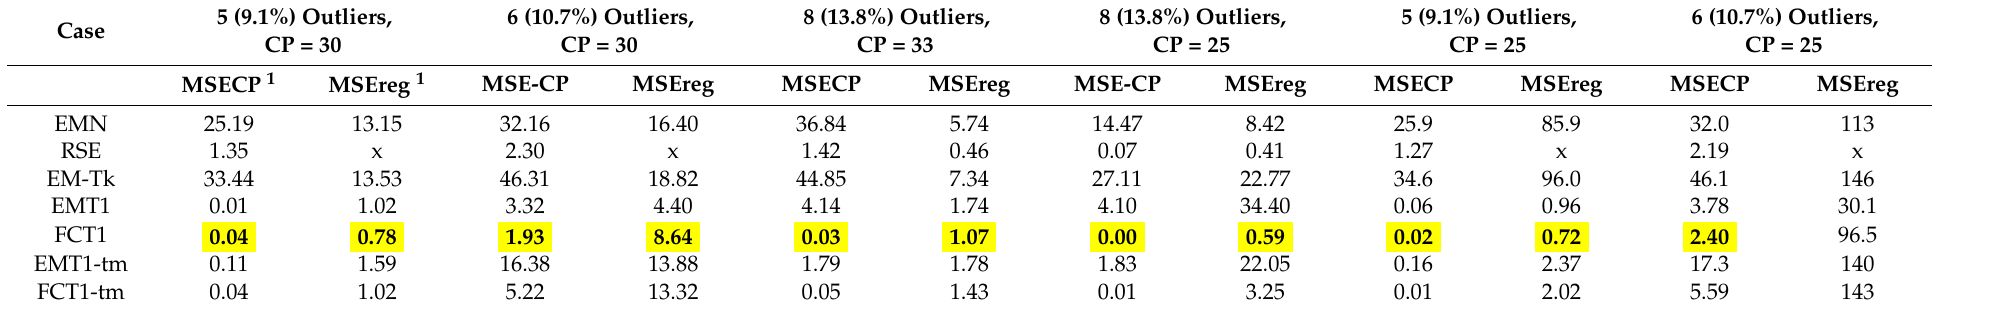
Table 3. Comparing the robustness of 7 methods to extreme outliers using model b under four